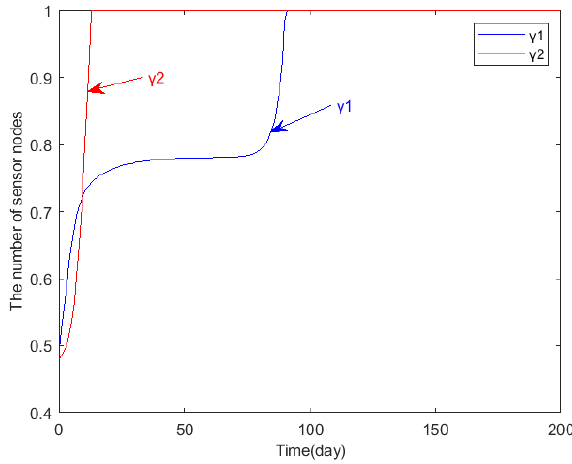
Figure 8. Evolution of control variables.